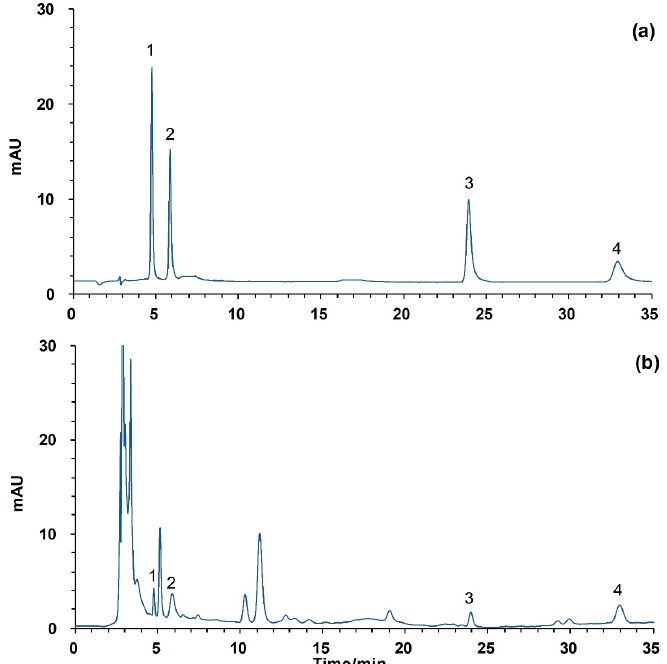
Figure 3. The HPLCchromatograms for standards ( a ) and extract from Mairei Yew leaves ( b ). Peak 1 for QU (quercetin), Peak 2 for KA (kaempferol), Peak 3 for GI (ginkgetin) and Peak 4 for SC (sciadopitysin).